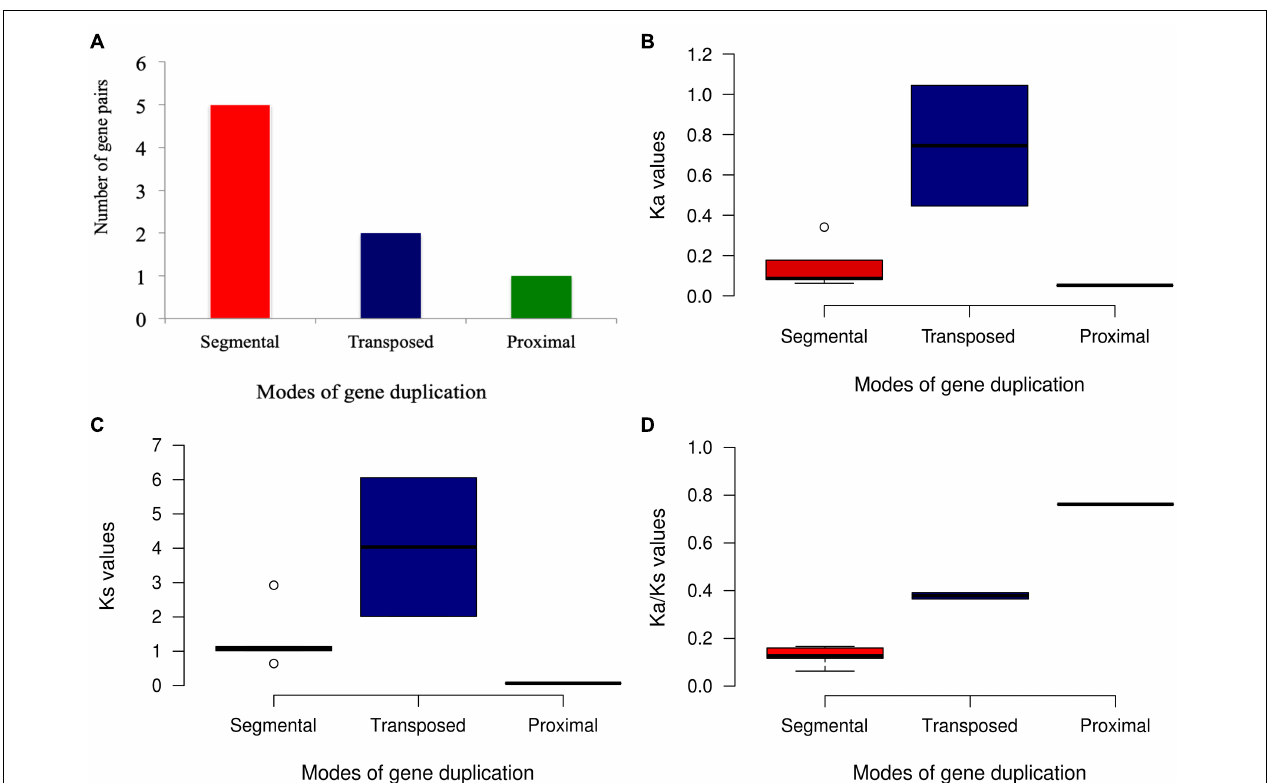
FIGURE 6 | Evolutionary patterns of duplicated START gene pairs by different modes in Oryza sativa var. japonica. (A) Gene pair distribution among different modes of duplication. (B) Ka values of duplicated gene pair. (C) Ks value of duplicated gene pairs. (D) Ka/Ks values of duplicate genes